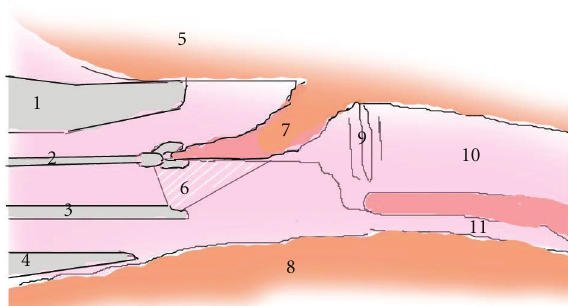
Figure 2: Surgical schema. The endotracheal intubation tube is omitted from this diagram. (1) Upper tip of Weerda-type laryngo- scope. (2) Grasping forceps. (3) Rigid nasal sinus surgery endoscope at 70 ◦ . (4) Lower tip of Weerda type laryngoscope. (5) Lingual tonsil. (6) Scope of field of view of rigid endoscope. (7) Epiglottis. (8) Retropharyngeal wall. (9) Glottic space. (10) Trachea. (11)